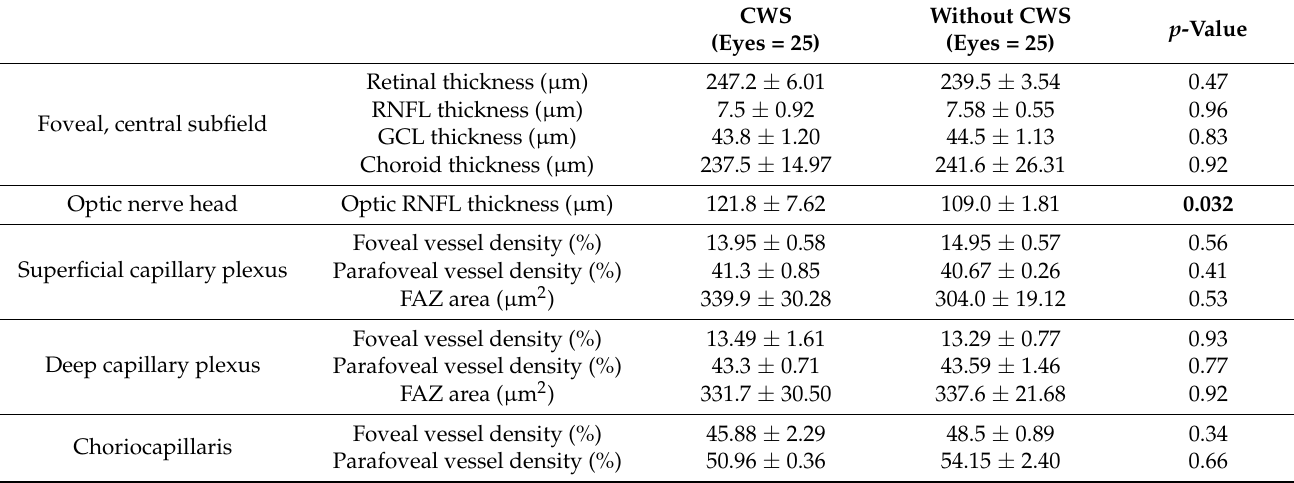
Table 3. Subgroup analysis in COVID-19 patients with and without cotton wool spots (CWS). Mean ± SEM (standard error of the mean) structural OCT and OCTA values. Retinal nerve fiber layer (RNFL), ganglion cell layer (GCL), superficial capillary plexus (SCP), foveal avascular zone (FAZ), deep capillary plexus (DCP), and choriocapillaris (CC). p -values correspond to a comparison between subgroups. Bold values denote statistical significance at the p < 0.05